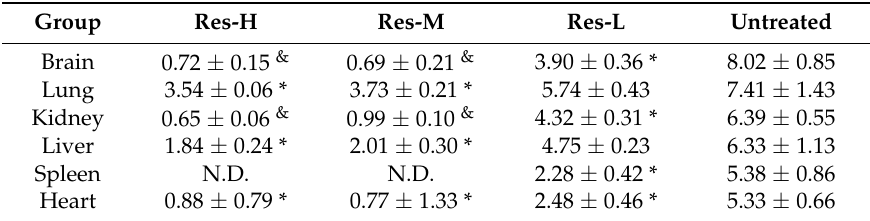
Table 2. Lesional scores for each group at 7 dpi a